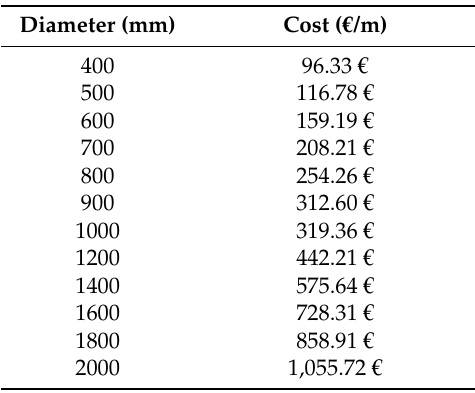
Table 3. Cost of conduits.